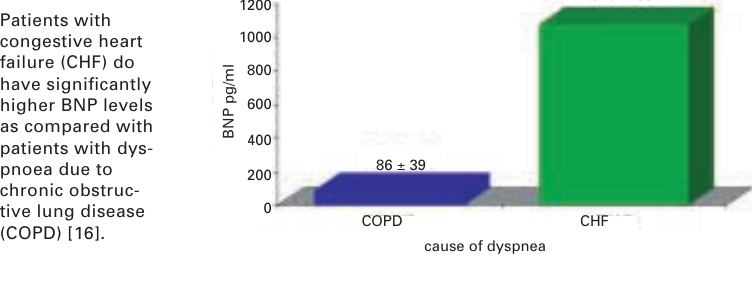
Correlation between the clinical severity of heart failure and BNP levels in the Breathing Not Prop- erly (BNP) Multina- tional Study [19].